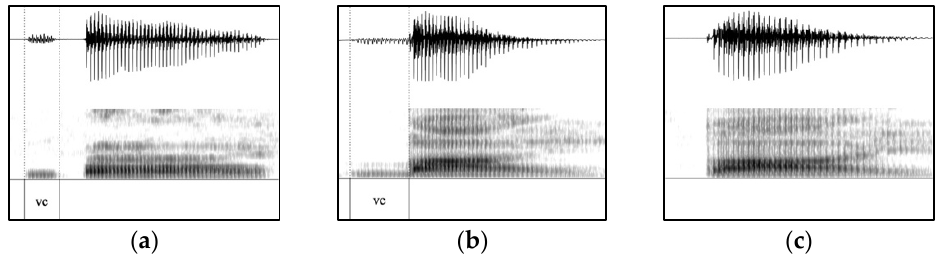
Figure 2. Examples of tokens produced with and without prevoicing (labeled as ‘vc’ when present): ( a ) Imitation of English [baj] by a monolingual English speaker with voicing present; ( b ) Imitation of English [baj] by a Cantonese ‐ English speaker with voicing present; ( c ) Imitation of English [b ̥ aj] by the same Cantonese ‐ English speaker with voicing absent.